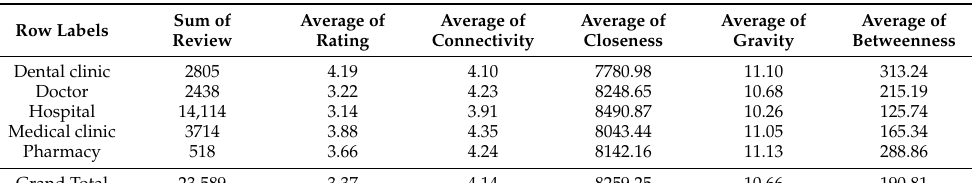
Table 8. Perception of Healthcare Facility Services and Global Spatial Review Configuration by Google POI.